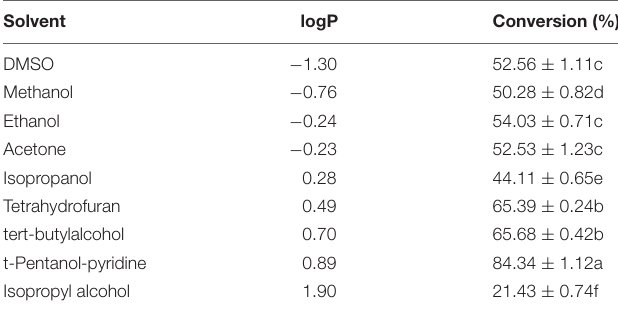
TABLE 2 | Effect of Organic Solvents on Acylation of Neohesperidin Catalyzed by